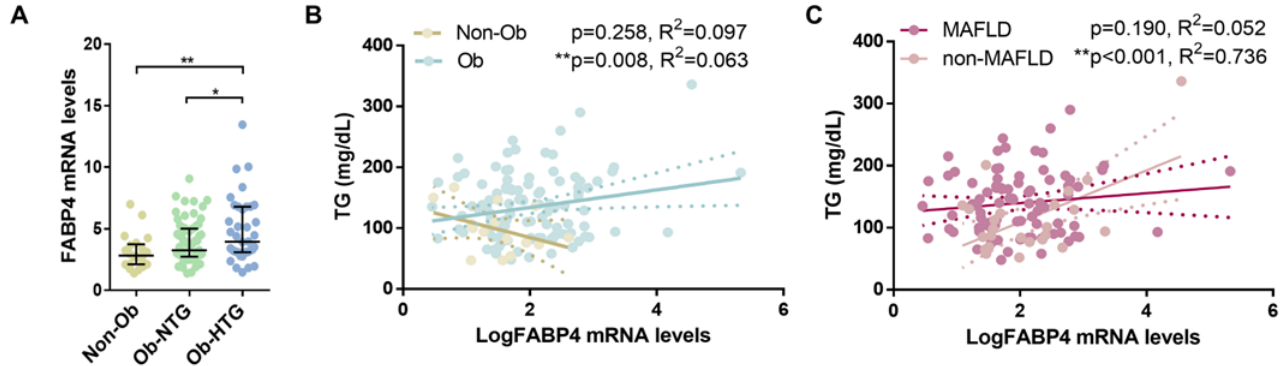
Figure 3. Comparison of SAT-FABP4 mRNA levels between groups and regression analysis with circulating TG levels. ( A ) FABP4 expression in SAT from normotriglyceridemic non-obese (Non-Ob), normotriglyceridemic obese (Ob-NTG) and hypertriglyceridemic obese (Ob-HTG) individuals. Data are presented as median with interquartile range. Kruskal–Wallis H(3) = 10.32, p = 0.005. ( B ) Simple regression analysis between SAT-FABP4 expression and TG levels in subjects with (Ob) and without obesity (non-Ob). Scatterplot presents crude, non-adjusted, relationships. ( C ) Regression analysis between SAT-FABP4 expression and TG levels in obese subjects with or without MAFLD. Simple linear regression (solid line) and 95% confidence interval (dashed line) are shown. p -values are adjusted for BMI, HbA1c, creatinine, GGT and statin treatment. * = p < 0.05; ** = p < 0.01. Table 4. Summary of hierarchical regression analysis for variables predicting circulating TG levels in subjects with